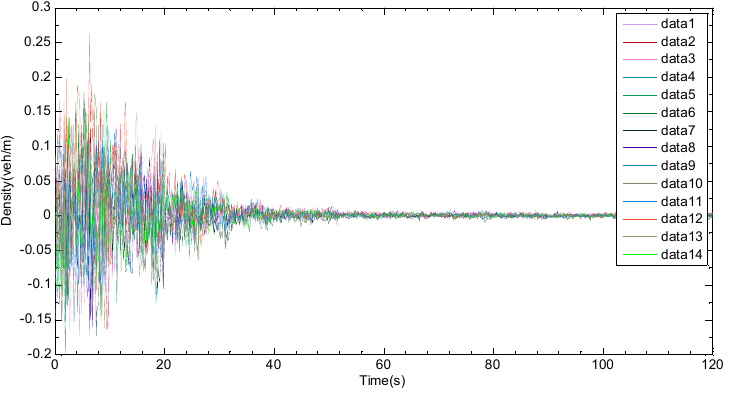
Figure 5. Error curve of synchronous observer.